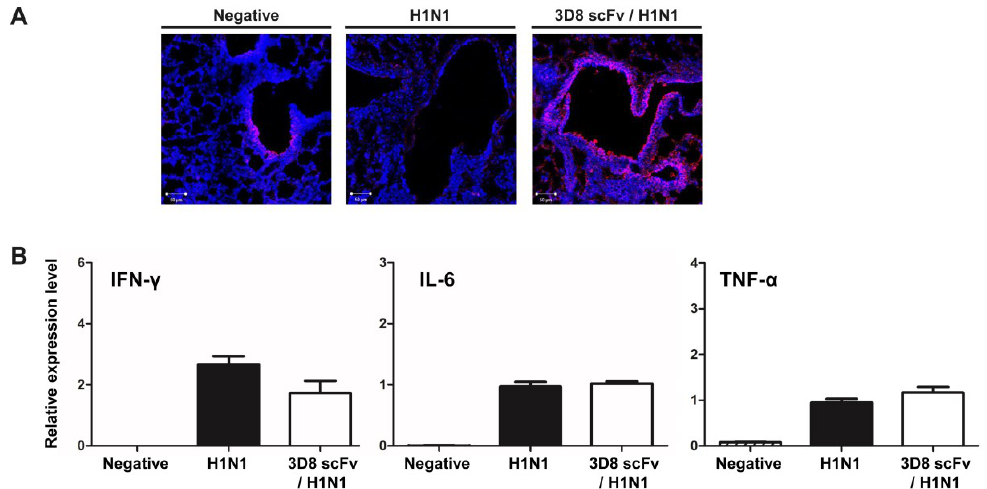
Figure 4. Penetration of 3D8 scFv into the epithelium of the nasal mucosa and analysis of cytokine and chemokine expression. ( A ) The presence of 3D8 scFv in the epithelium of the nasal mucosa of the lung was detected by immunohistochemistry. Lung tissues were stained with anti-3D8 scFv polyclonal Ab and visualized using a TRITC-conjugated anti-rabbit secondary Ab and fluorescence microscopy. Mice were treated with or without 3D8 scFv for 5 days and then challenged. After virus challenge, lung samples were extracted from each group on days 3 and 6 p.i. ( B ) mRNA expression of the indicated cytokines and chemokines was measured by qRT-PCR with primers against IFN-β, IFN-γ, or GADPH.